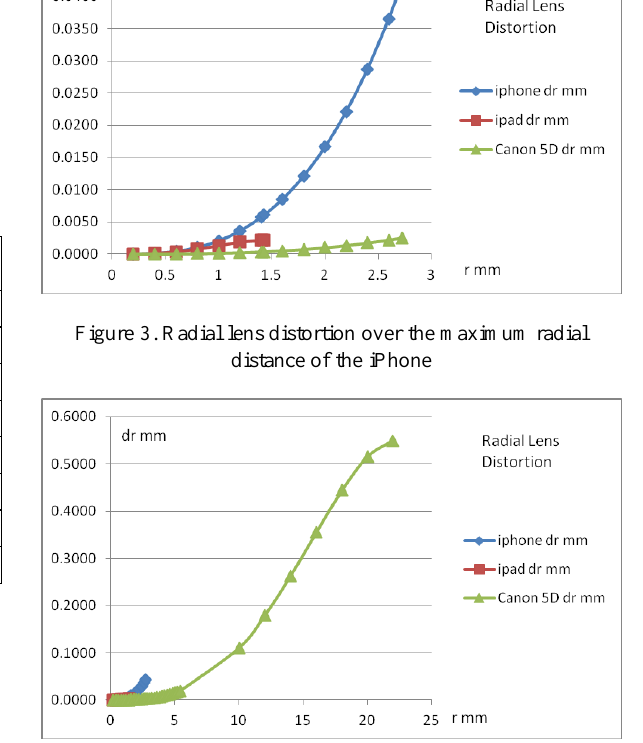
Figure 4. Radial lens distortion over the maximum